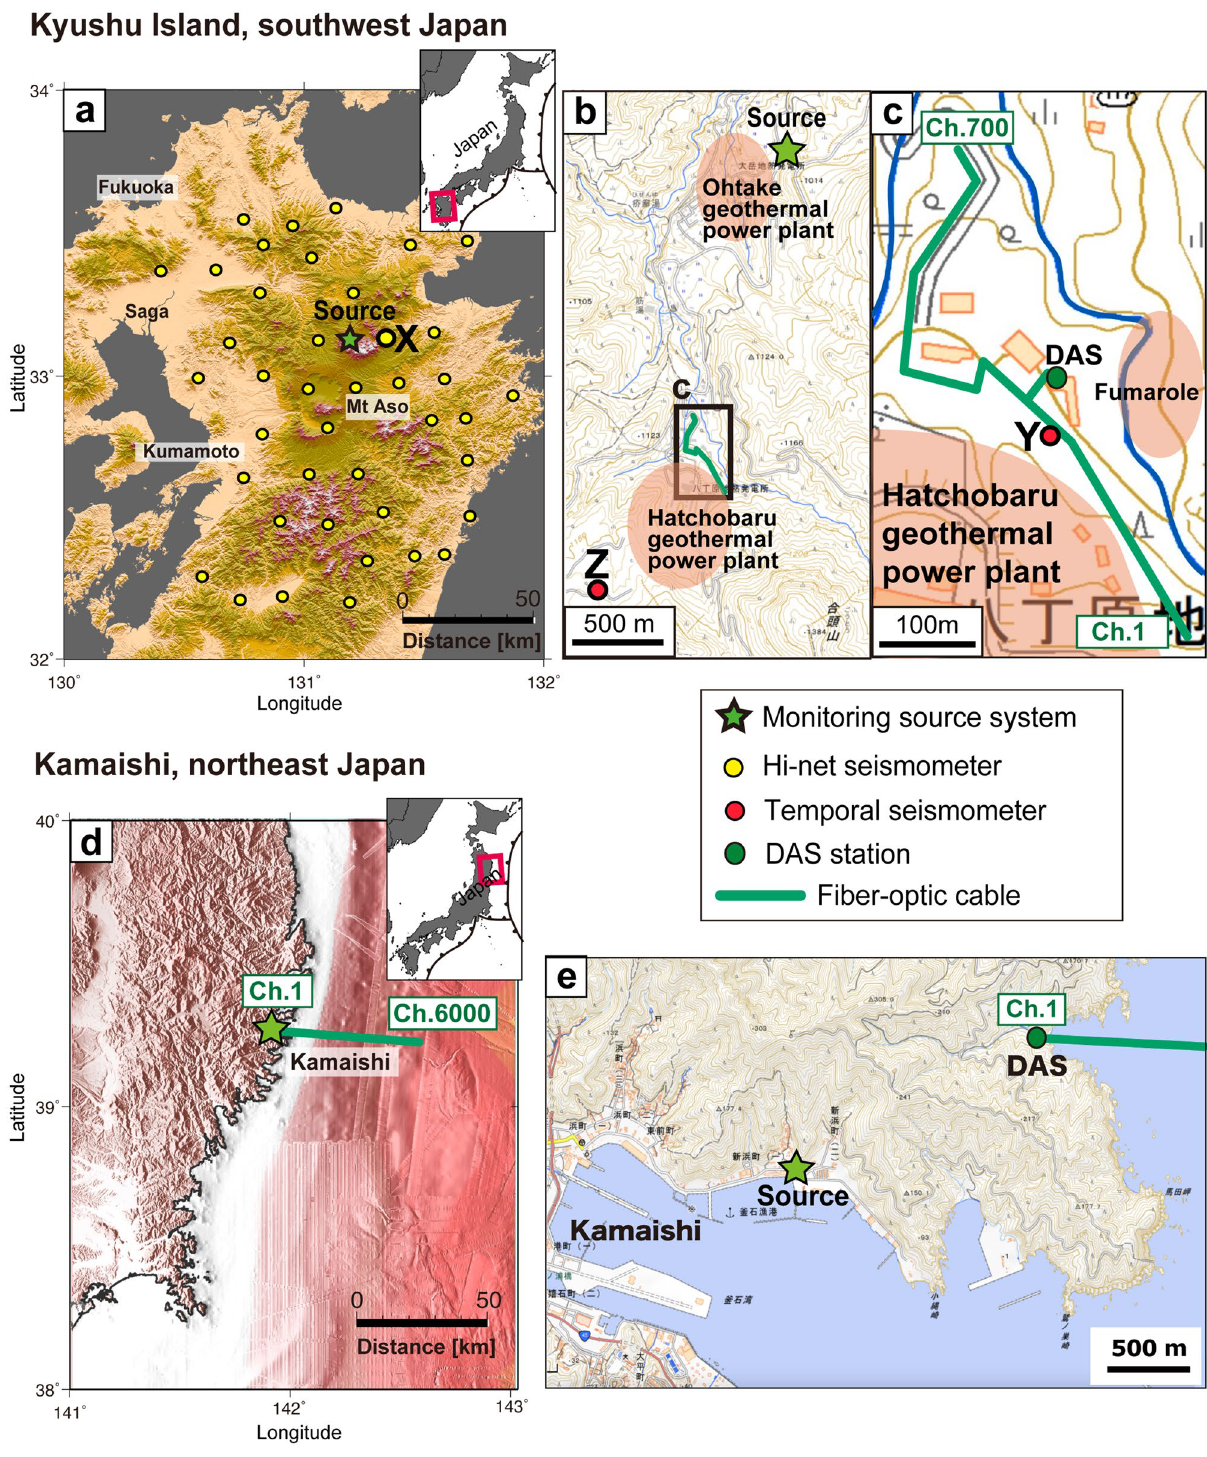
Figure 2. Locations of the continuous monitoring source system, seismometers and fiber-optic cable for DAS. ( a ) Locations of the monitoring source system (green star) and Hi-net seismometers (yellow dots) in the Kuju geothermal field of central Kyushu, southwest Japan. ( b ) Locations of the source system, the temporal seismometers Z (red dot) and fiber-optic cable for DAS (green line). This map includes the locations of 2 geothermal power plants (red shaded areas). ( c ) Positions of the fiber-optic cable (green line) and three-component seismometers Y (red dot). ( d ) Locations of the monitoring source system (green star) and the fiber-optic cable used in this study for DAS (green line) in Kamaishi, northeast Japan. ( e ) Relative locations of source system and fiber-optic cable for DAS. The distance between the source and DAS station is ~ 1.6 km. The base map in panel ( a ) is a 10-m-mesh digital elevation model published by the Geospatial Information Authority of Japan 44 . Panel ( a ) is modified from Nimiya et al. 12 . The base map in panel ( d ) is from JCG and JAMSTEC 45 . We drew the panels ( a ) and ( d ) with Generic Mapping Tools 46 . The base maps in panels ( b , c , e ) are modified from the Geospatial Information Authority of Japan (http:// maps. gsi. go.